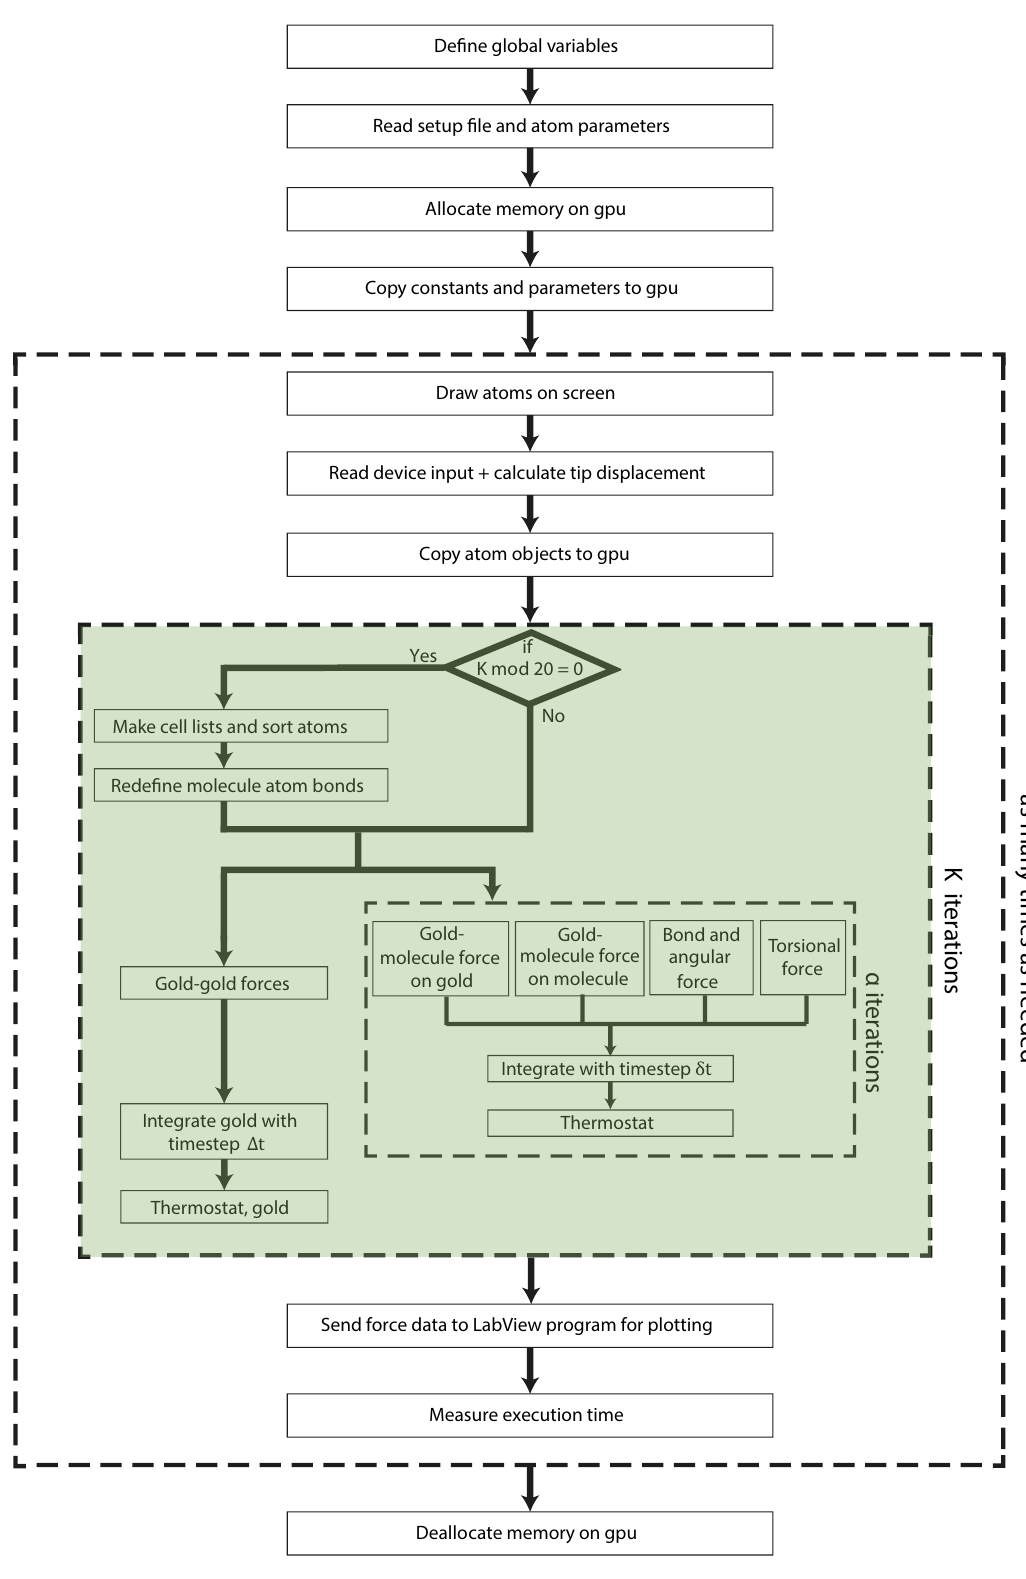
Figure 2. Flowchart showing the execution scheme of the program. Time runs in the vertical direction; thus, subroutines placed next to each other run in parallel. Parts of the chart contained in dashed boxes run as many times as stated to the right of the boxes,